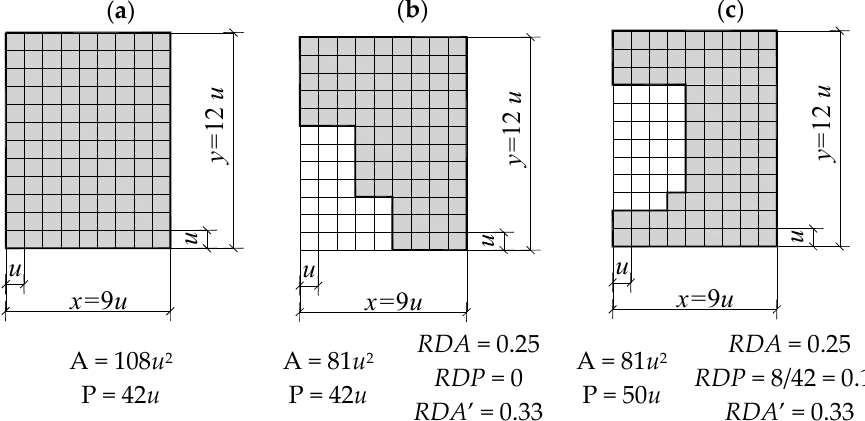
Figure 1. Rectangular polygons ( x × y , where x = 9 u and y = 12 u ) and their associated rectangles: ( a ) with a large 81% area defect, A R − A = 88 u 2 , RDA = 0.81 and zero’s perimeter defect, RDP = 0, ( b ) with a 57% perimeter defect, P – P R = 24 u , RDP = 0.57 and, with a 35% area defect, A R − A = 38 u 2 , RDA = 0.35, and ( c ) with a 95% perimeter defect, P − P R = 40 u , RDP = 0.95 and, with a 41% area defect, A R − A = 44 u 2 , RDA = 0.41 (taken from [14] with permission from the authors).